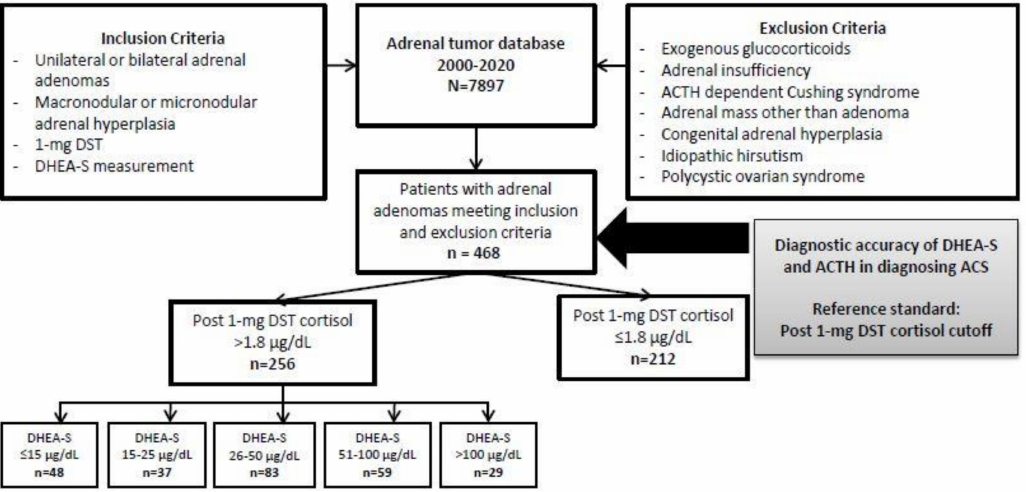
Figure 1. Flowchart of study population. Abbreviations: ACTH, corticotropin; DHEA-S, dehydroepiandrosterone sulfate; DST, dexamethasone suppression test; ACS, mild autonomous cortisol secretion; NFAT, nonfunctioning adrenal